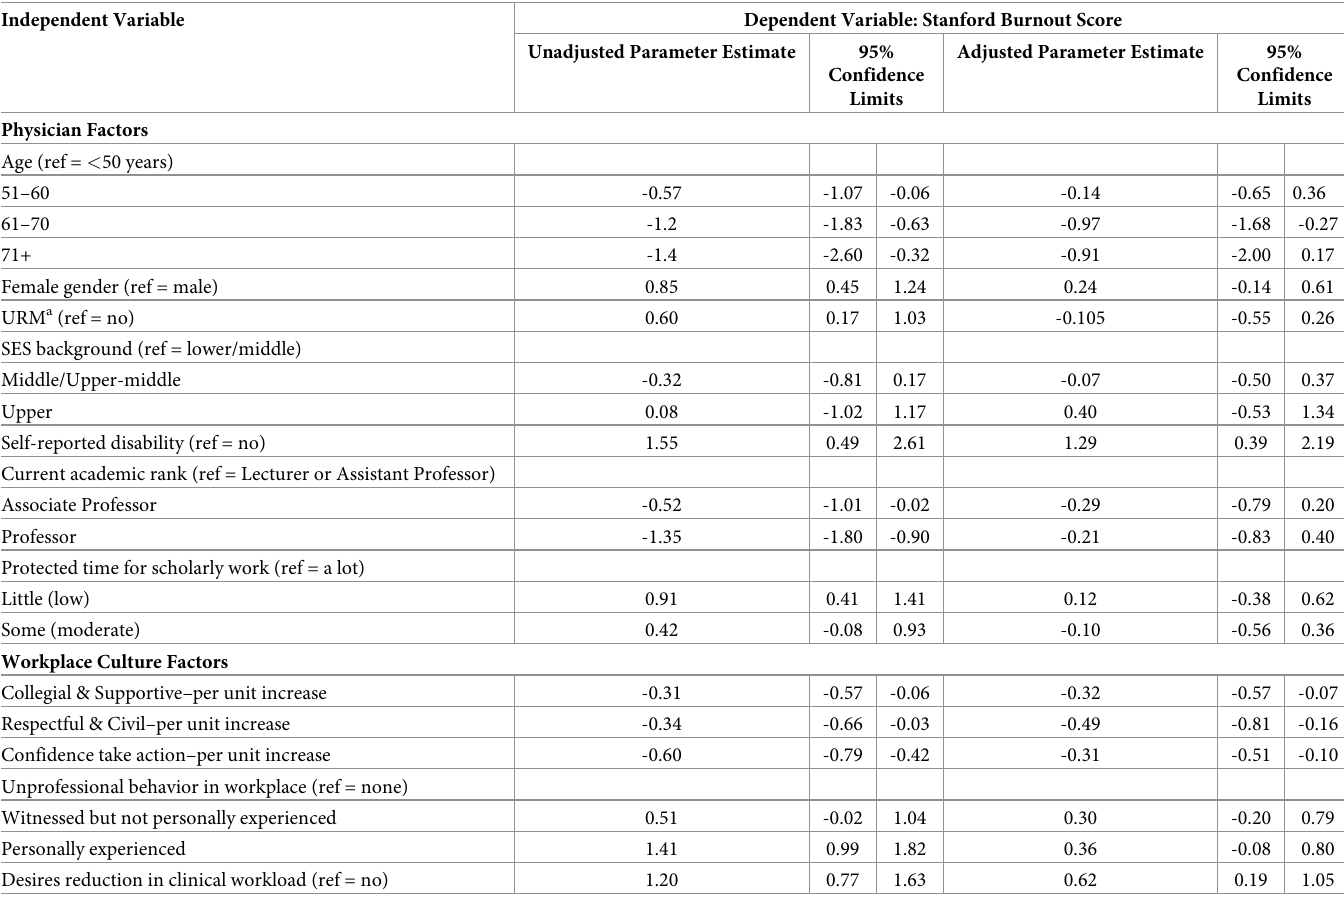
Table 4. Relationship of physician and organization factors to symptoms of burnout–results of linear regression